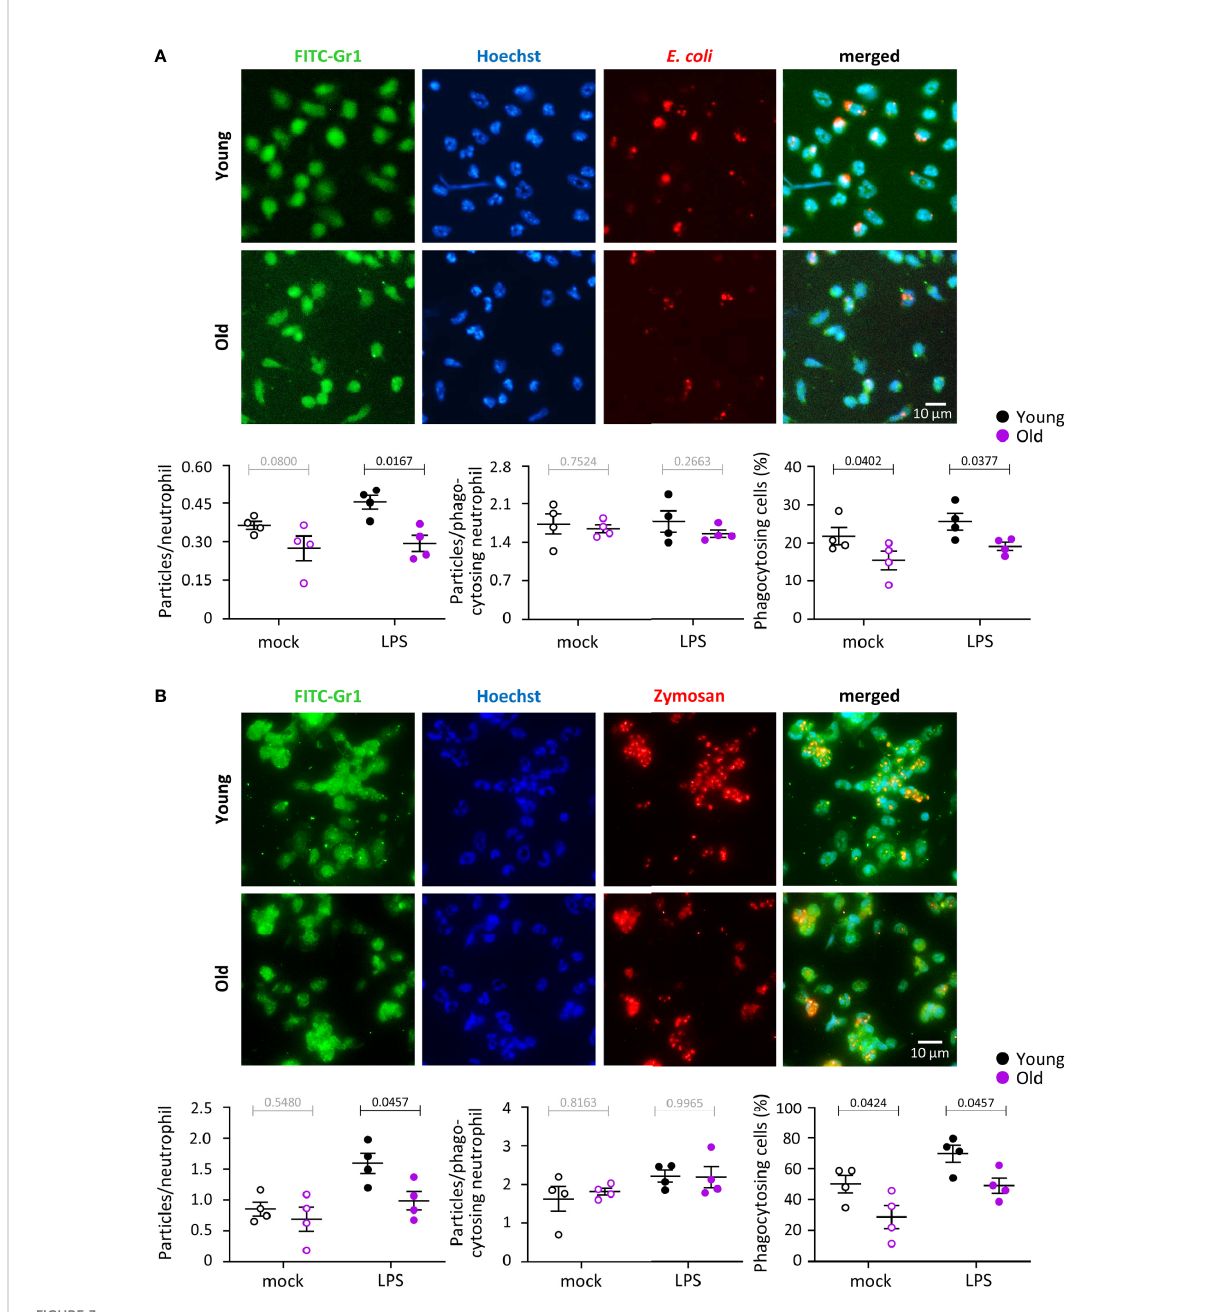
FIGURE 3 Hornigold K et al. Phagocytosis is impaired in neutrophils from old mice, in part through effects of LPS. Neutrophils from young (8-10 weeks, black symbols) and old (24 months, purple symbols) mice were primed with 1 m g/ml LPS for 90 min at 37°C (closed symbols), or were mock- primed (open symbols), and then plated onto glass coverslips for 15 min and stimulated either with IgG-opsonised E. coli (25 bacteria per neutrophil) for 120 min at 37°C (A) , or with IgG-opsonised zymosan yeast particles (5 particles per neutrophil) for 30 min at 37°C (B) . Cells were fi xed, stained with FITC-Gr1 and AF568-IgG antibodies and Hoechst DNA dye, and assessed for the number of E. coli or zymosan particles within by wide fi eld microscopy and ImageJ analysis. Representative images from one experiment are shown. Graphs in (A) and (B) show the quanti fi cation by ImageJ analysis for the number of particles per neutrophil overall (left panel), number of particles in neutrophils which had taken up at least one (middle panel), and proportion of phagocytosing neutrophils (right-hand panel). Data in (A) and (B) are mean ± SEM of 4 independent experiments; each dot represents the mean of one experiment. Statistics are two-way ANOVA with Sidak ’ s multiple comparisons tests; black p-values are signi fi cant, grey p-values non-signi fi